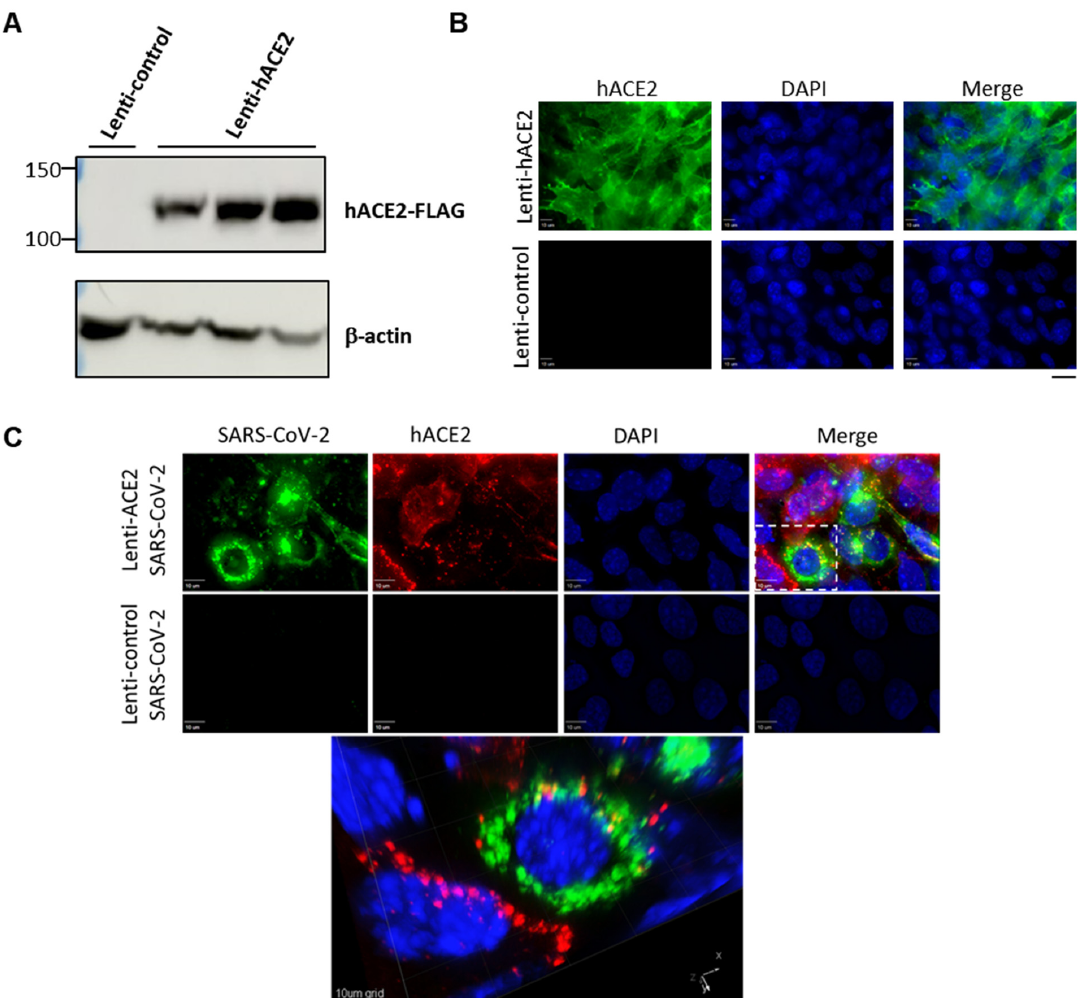
Figure 1. Expression of hACE2 in lentiviral-transduced murine cells allows for productive SARS-CoV-2 infection. ( A ) Western blotting analysis of lentiviral-transduced LET1 cells shows the expression of hACE2 in LET1-hACE2-transduced cells. ( B ) Immunofluorescence staining analysis of hACE2 of Lent-hACE2 and Lenti-control-transduced LET1 cells. Scale bar—20 µ m. ( C ) Deconvolution microscopy of Lenti-hACE2 and Lenti-control-transduced LET1 cells infected with SARS-CoV-2. Top and lower rows depict a maximum-intensity projection of three-dimensional (3D) stacks, following deconvolution. Top row, cells were transduced with hACE-2 and infected with SARS-CoV-2; lower row, cells were transduced with control lentivirus and infected with SARS-CoV-2. Bottom micrograph is a 3D rendition of the inset appearing in the top row. 10 µ m bar in upper rows, 10 µ m grid in 3D